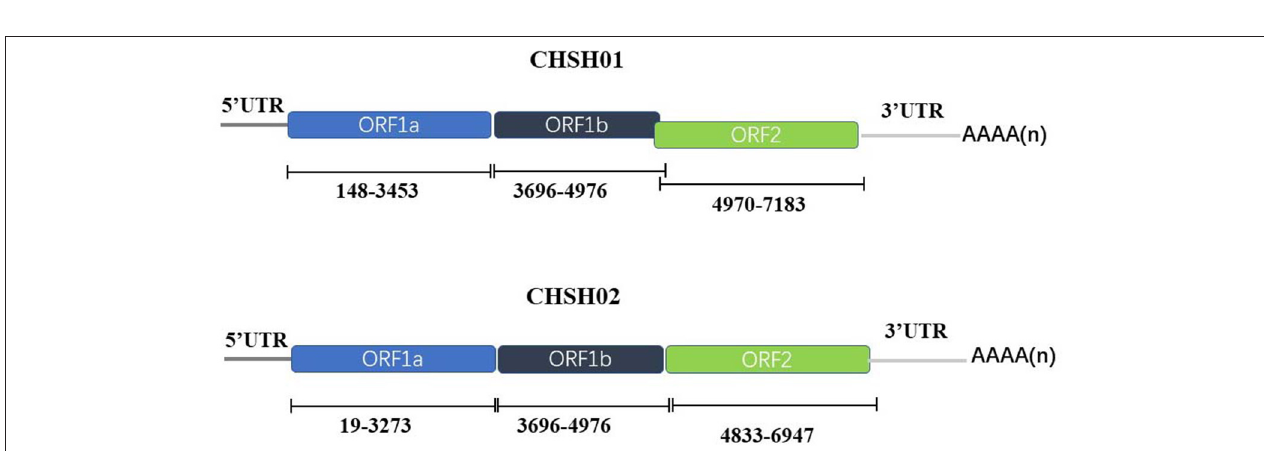
FIGURE 2 | Predicted genomic organization of CHSH01 and CHSH02. The genomic positions of viral proteins were indicated in the figure.